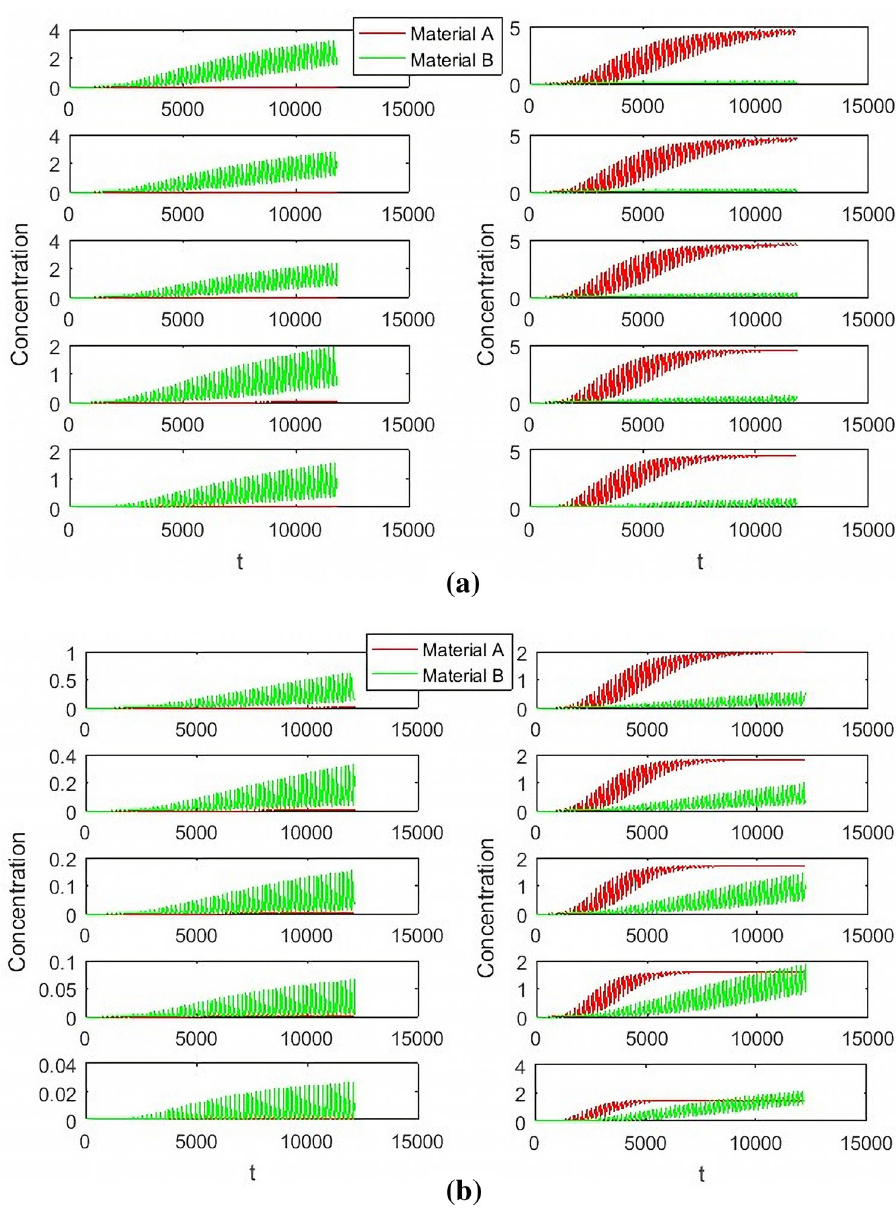
Figure 4. The influence of switching time on SMB